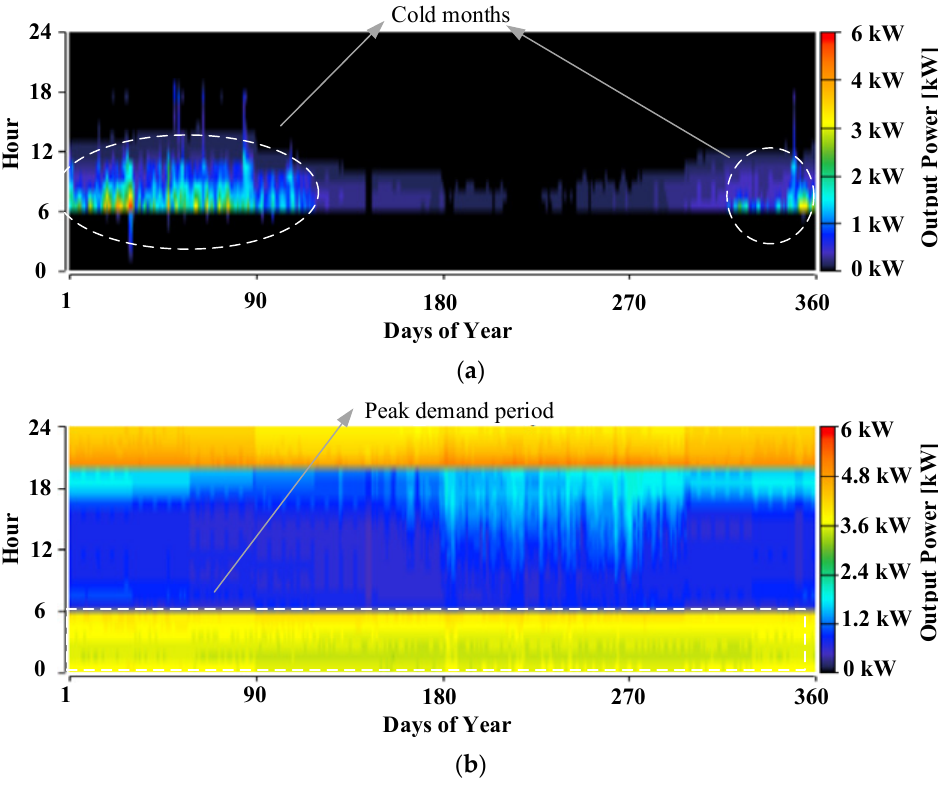
Figure 18. Hourly output power of thermal power suppliers: ( a ) gas boiler; ( b ) FC.